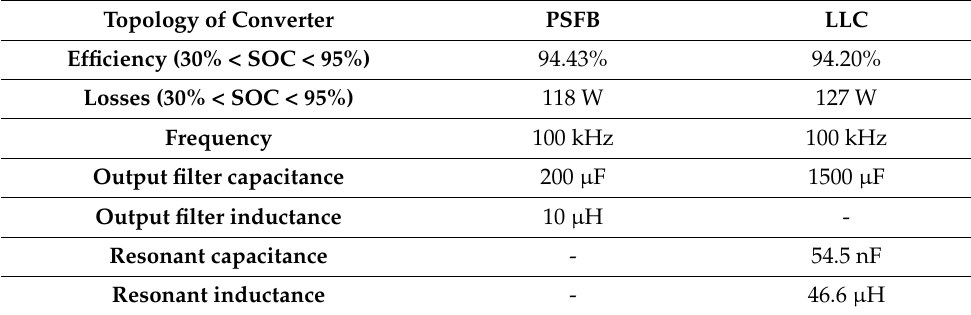
Table 5. Comparison table for LLC resonant converter and PSFB converter. Topology of